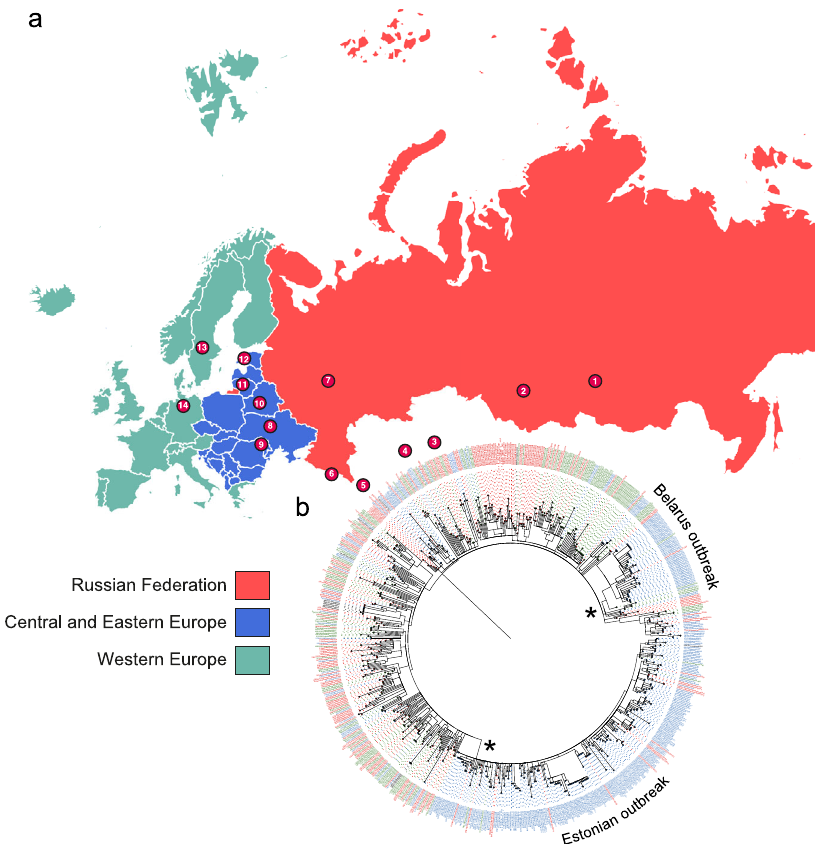
Fig. 1 | Sampling scheme of B0/W148 strains and phylogeographic expansion patterns in Eurasia. a Main locations (circled numbers and N ≥ 5) of sampled B0/W148 populations strati fi ed to three principle geographic regions (1